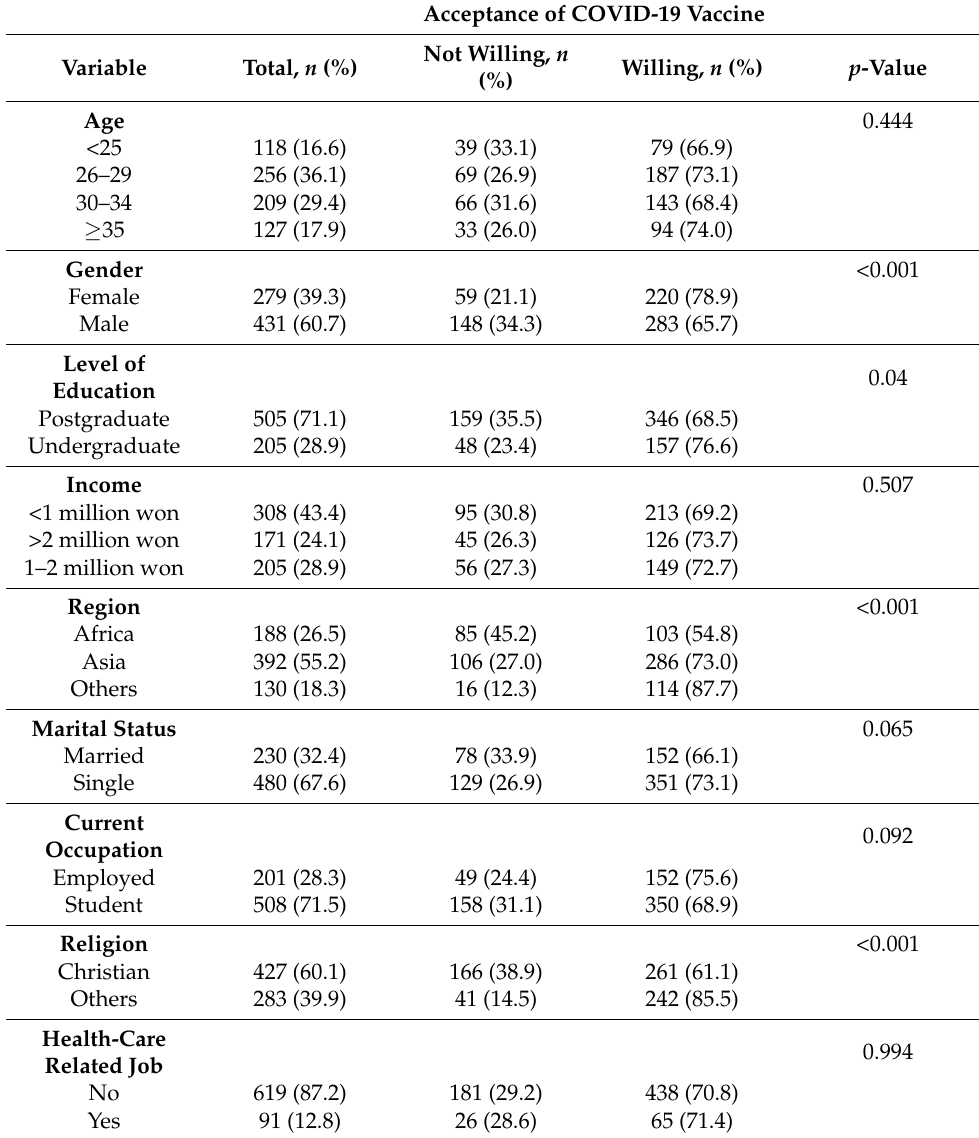
Table 2. Bivariate associations between sociodemographic characteristics and willingness to take the COVID-vaccine ( N = 710).